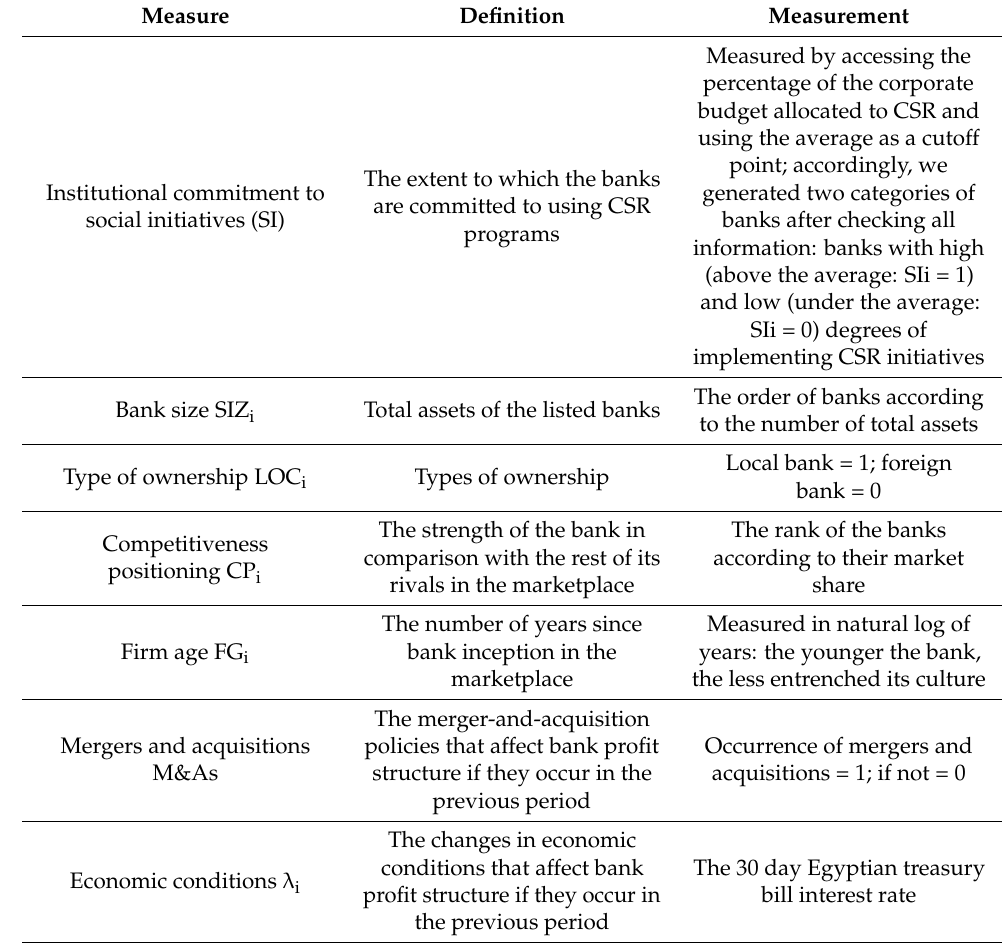
Table 1. Moderator measures to predict CSR impact on profit